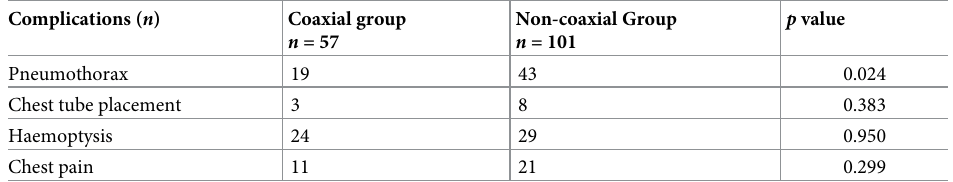
Table 5. The complications of both